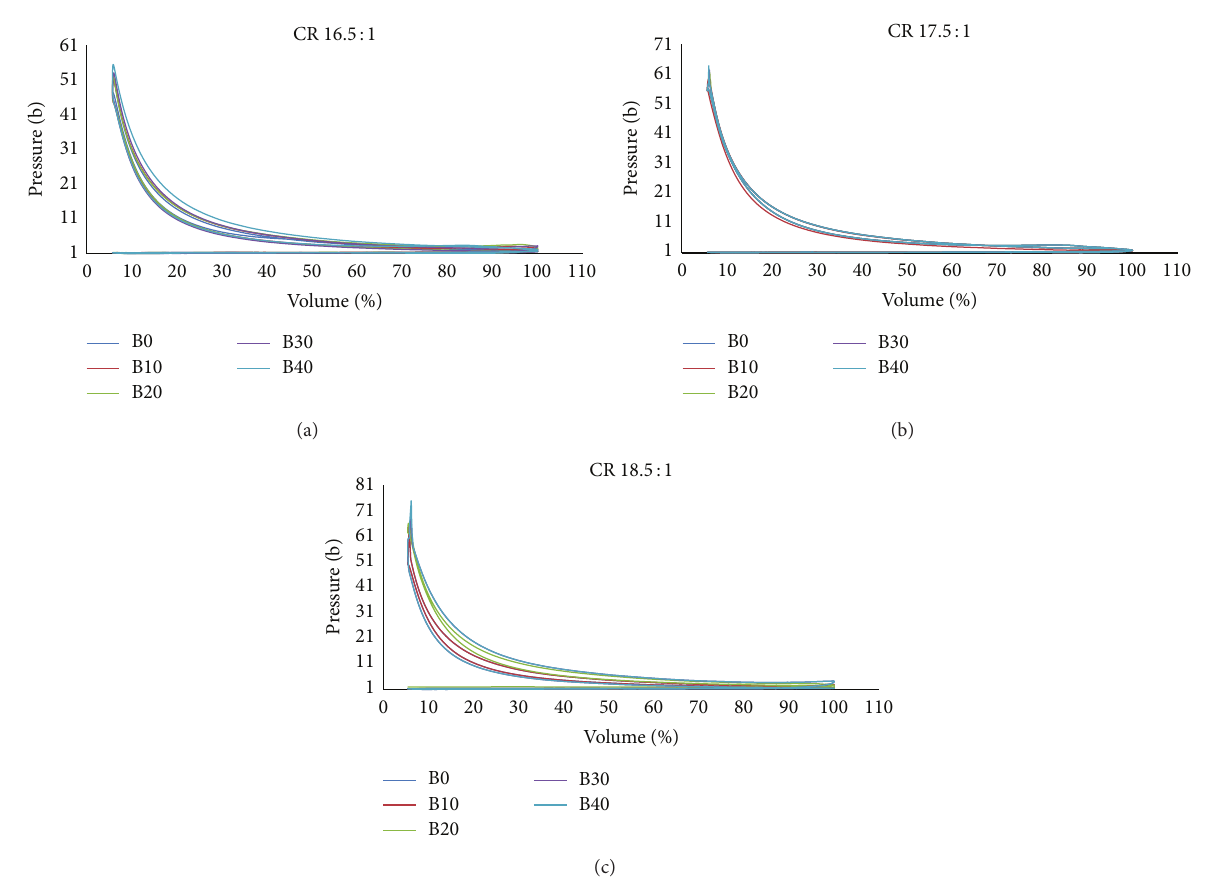
Figure 6: 𝑃 - 𝑉 diagram for diesel and ethyl ester blends at different compression